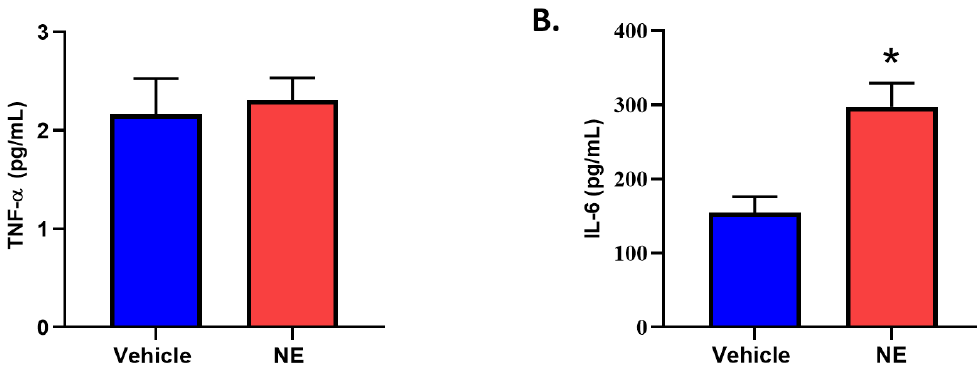
Figure 6. NE (10 µ M) treatment of HK2 cells promoted a significant elevation in IL-6 secretion but did not affect TNF- α secretion. ( A ) TNF- α levels in the supernatant of HK2 cells treated with Vehicle or NE for 24 h; data represented as mean ± SEM; n = 5/group. ( B ) IL-6 levels in the supernatant of HK2 cells treated with Vehicle or NE for 24 h; data represented as mean ± SEM; n = 5–6/group; * p = 0.0065.